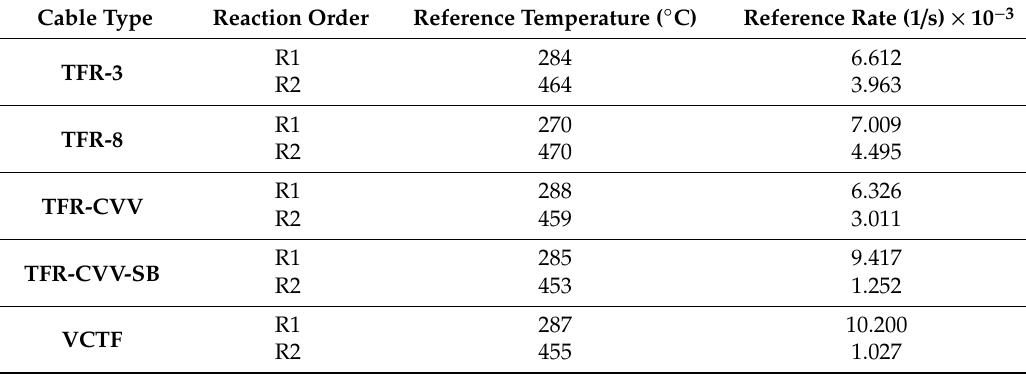
Table 2. Summary of TGA results related to reference temperature and rate for the flame retardant